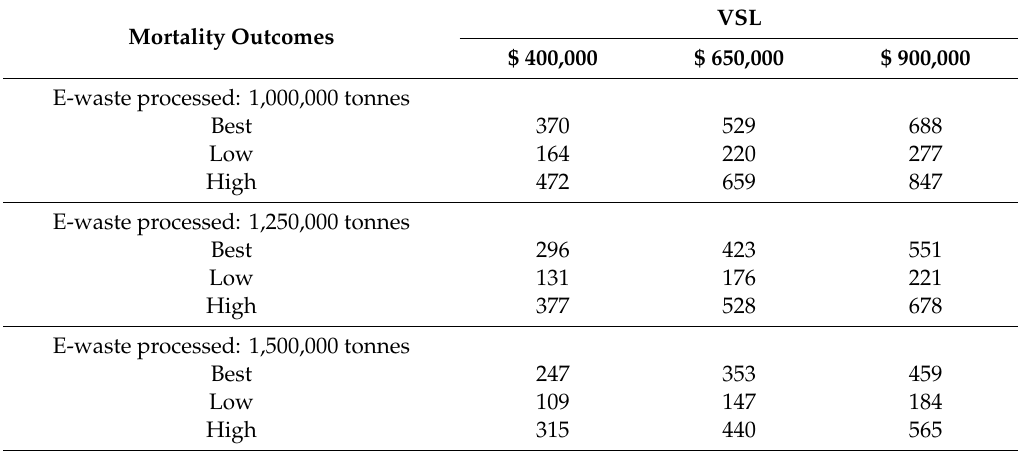
Table 5. Sensitivity Analysis: The Shadow Price of Informal E-waste Processing ($ / tonne) Varying Mortality Outcomes, VSL and the Amount of E-Waste